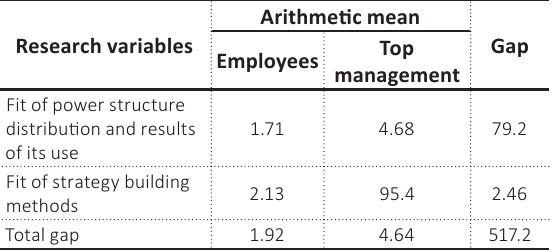
Table 1. Pilot study